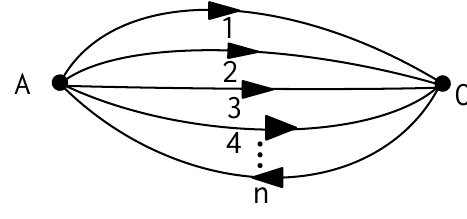
Figure 3. Signal flow diagram.